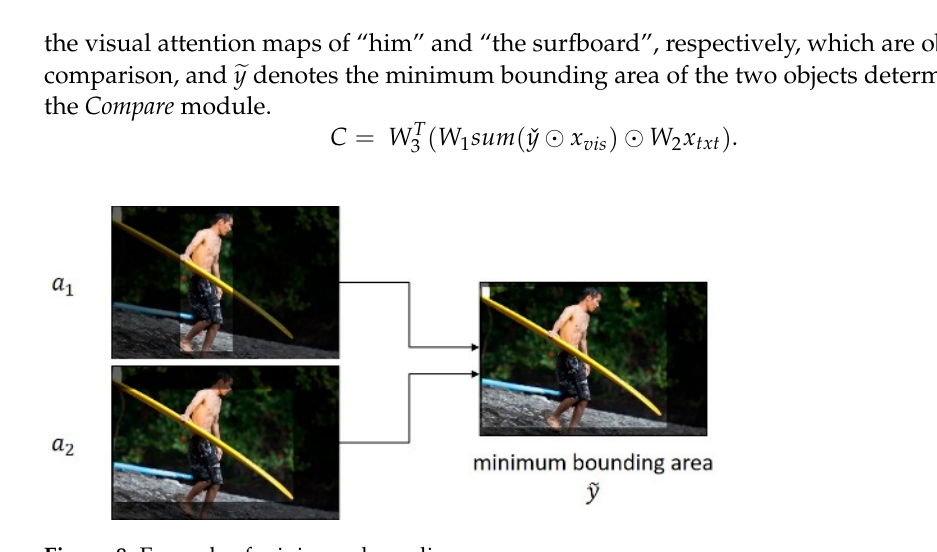
Figure 8. Example of minimum bounding area.